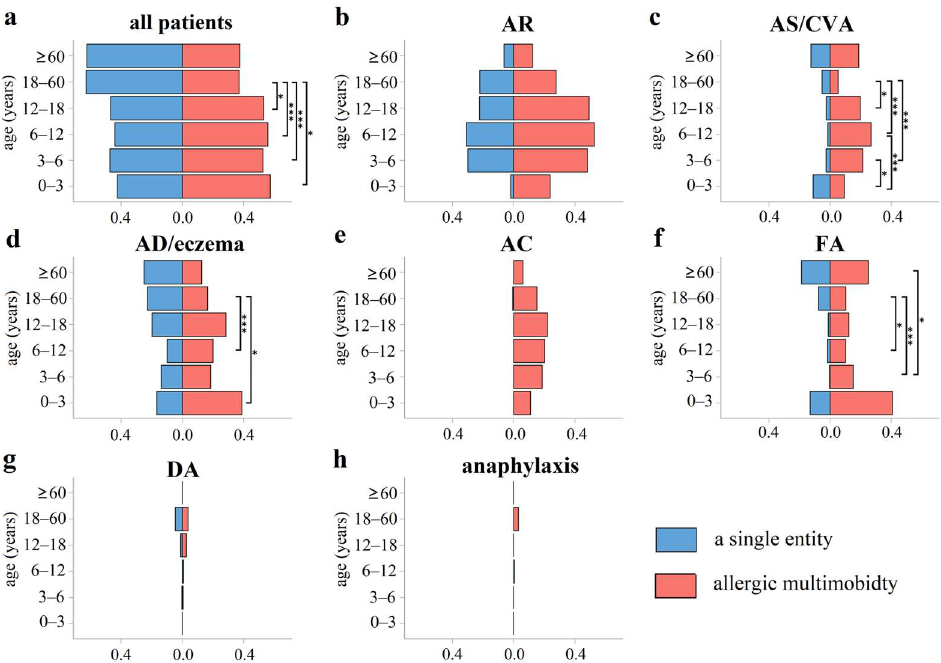
Figure 2. The proportion of allergic multimorbidities and a single entity by age. ( a ) All patients; ( b ) AR; ( c ) AS/CVA; ( d ) AD/eczema; ( e ) AC; ( f ) FA; ( g ) DA; ( h ) anaphylaxis. In general,